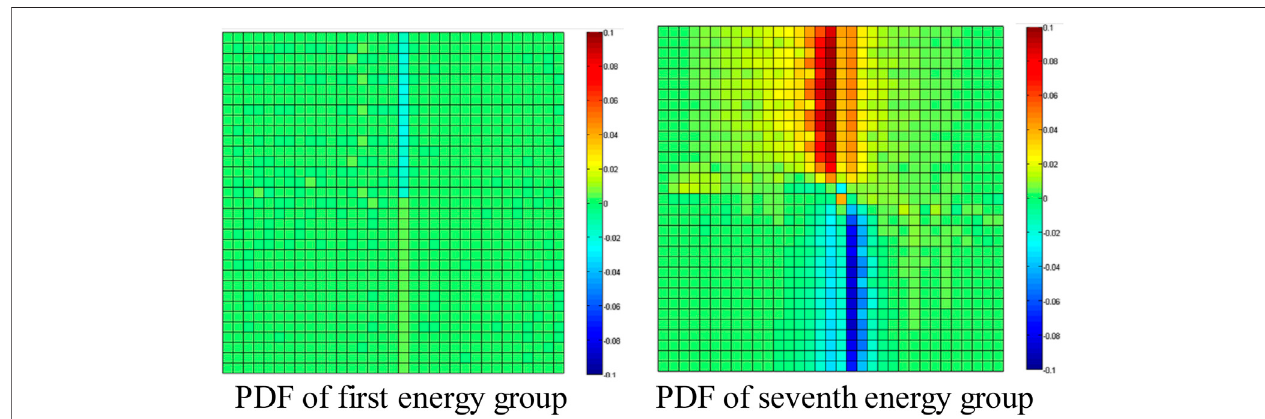
FIGURE 5 | Error distributions of the PDF ratio.